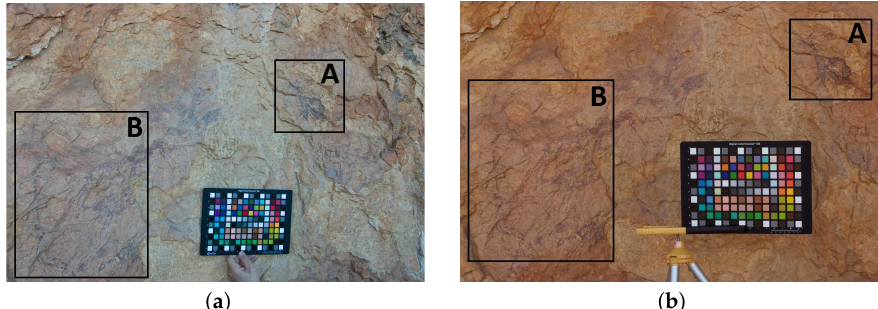
Figure 10. Selected rock art scenes: ( a ) SigmaSD15; ( b ) Fujifilm IS PRO. ( A ) Wounded animal detail. ( B ) Hunting